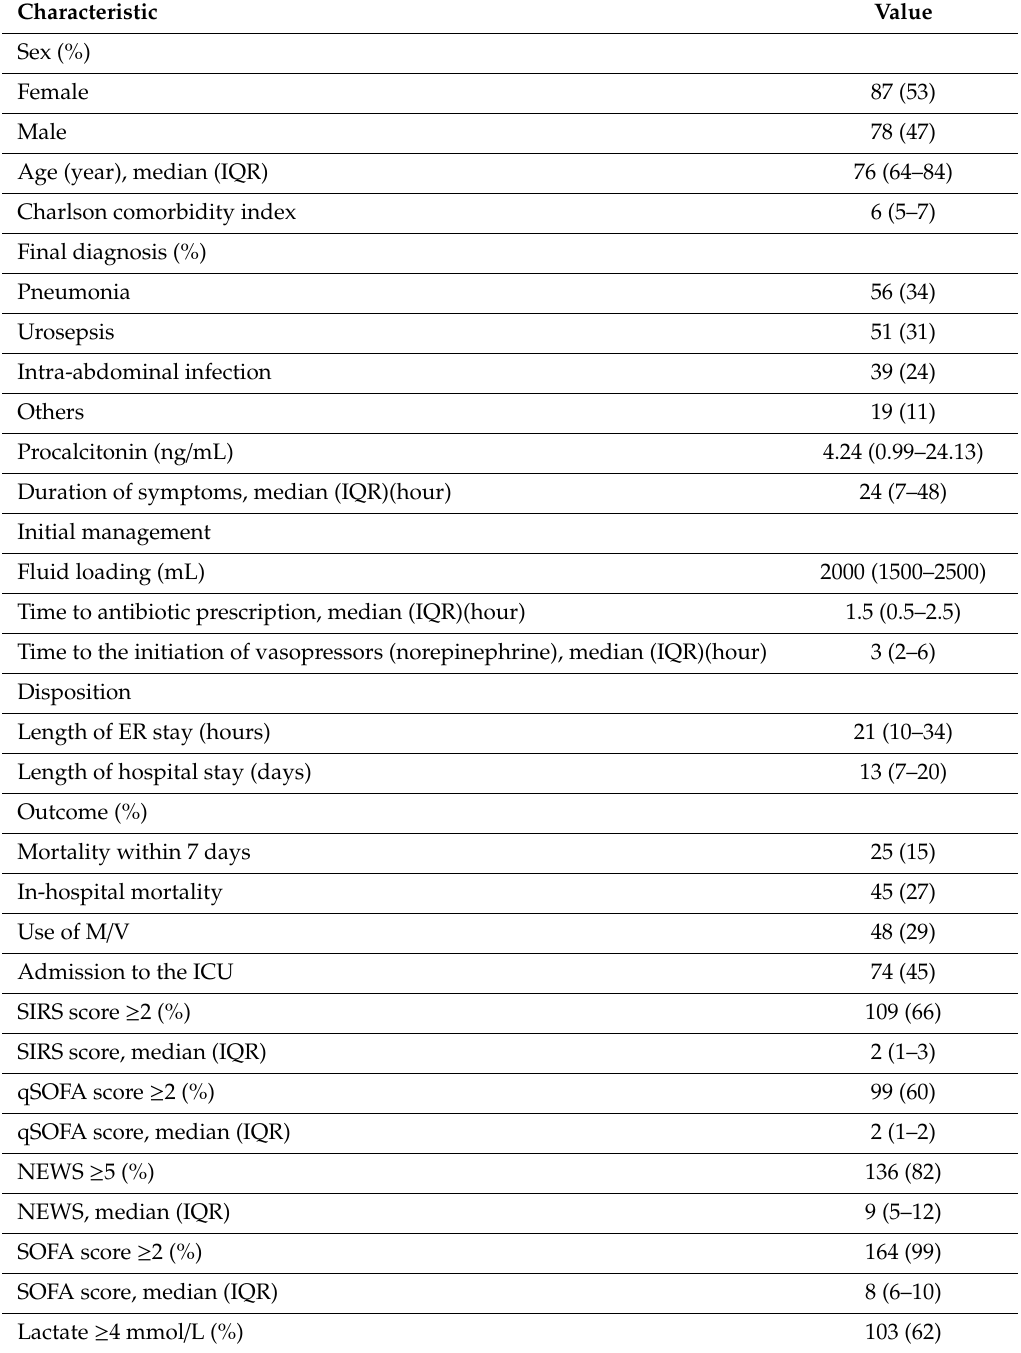
Table 1. Baseline characteristics of the